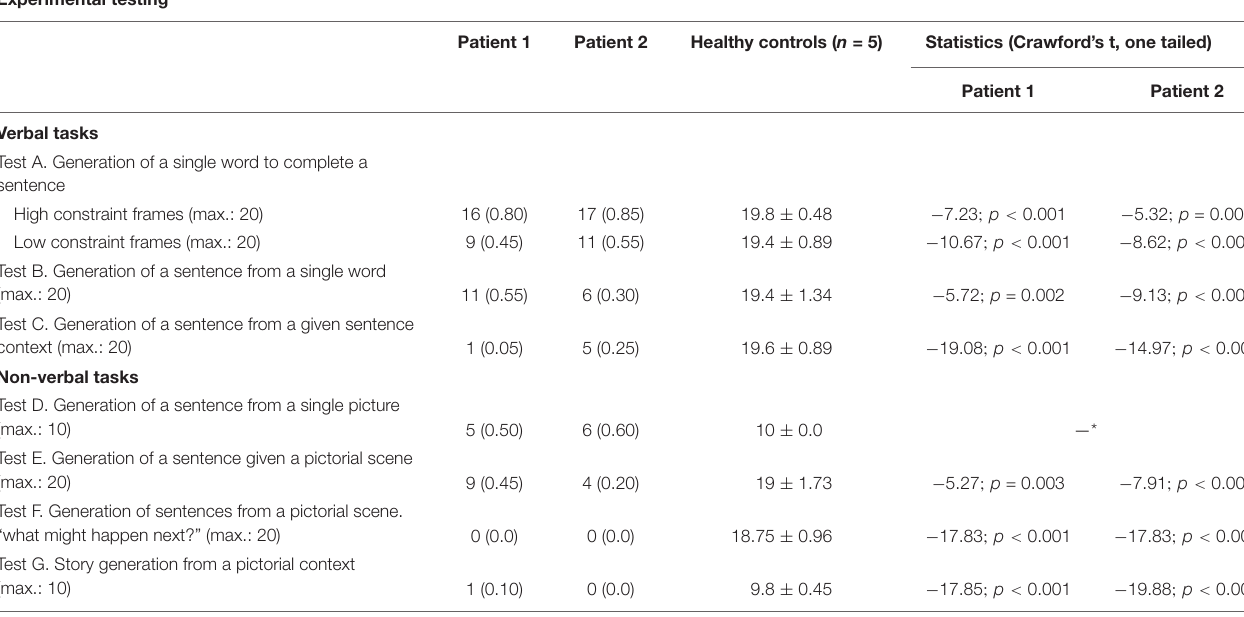
TABLE 3 | Testing of dynamic aphasia with verbal and non-verbal stimuli. Experimental testing